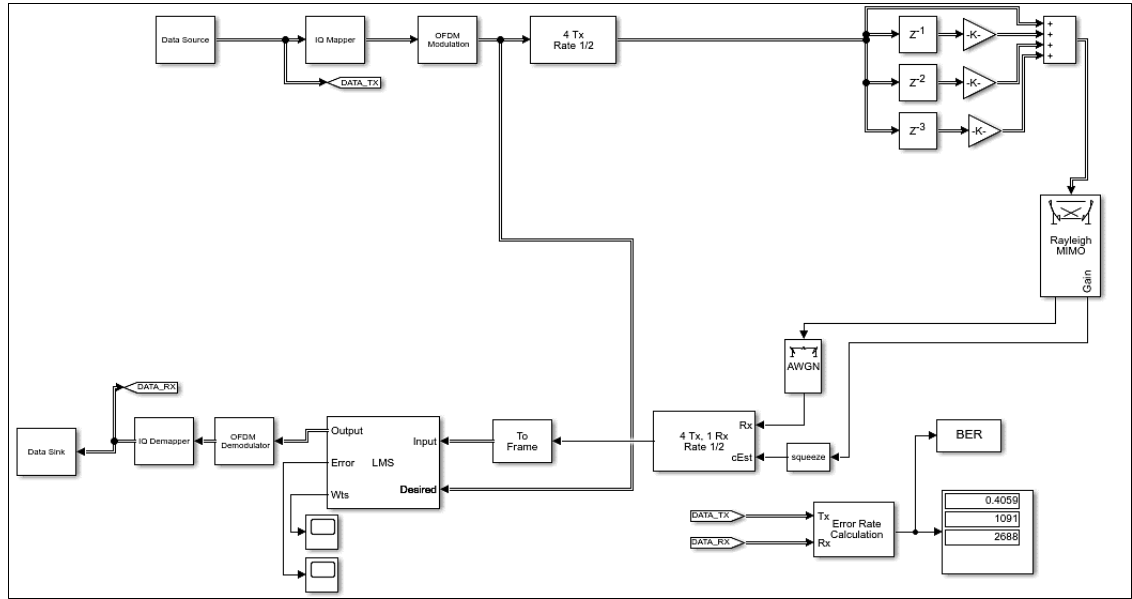
Figure 9. 4×1 LMS-MIMO-OFDM Model in Rician